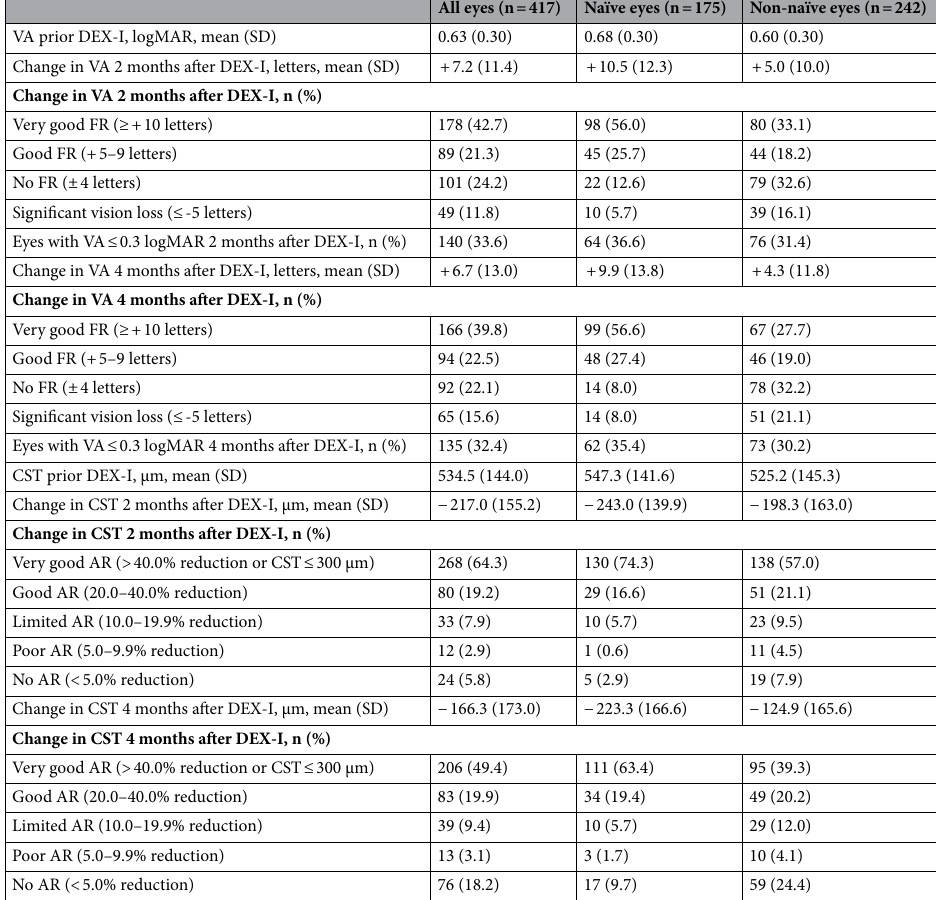
Table 2. Functional and anatomical outcomes. AR—Anatomical response, CST—Central subfield thickness, DEX-I—Dexamethasone implant, FR—functional response, SD—Standard deviation, VA—Visual acuity.